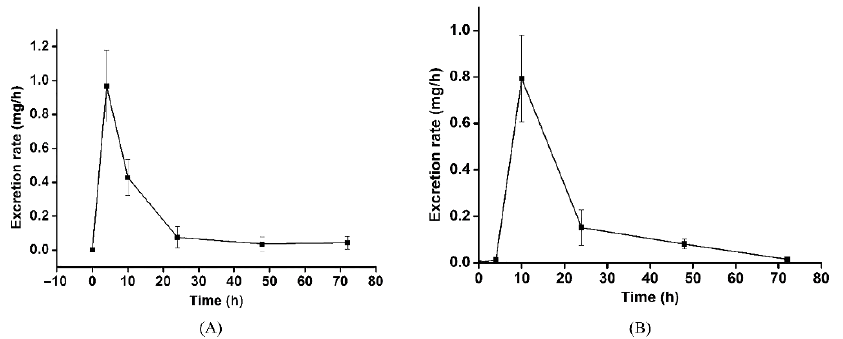
Figure 5. Excretion rate of LBP-FITC excreted in urine ( A ) and feces ( B ) after an oral dose of 50 mg/kg to rats.